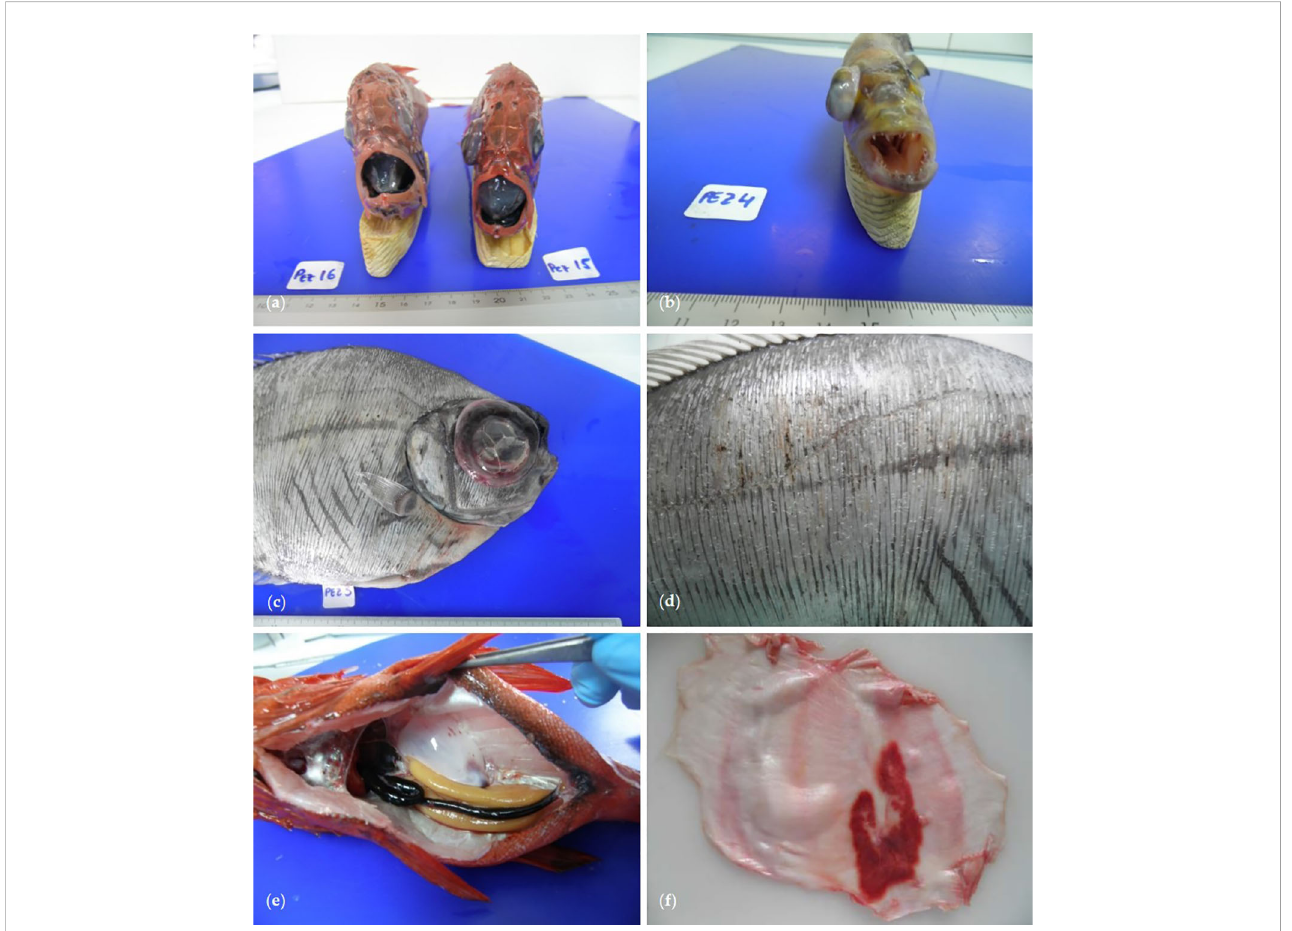
FIGURE 3 Macroscopy fi ndings in fi shes from El Hierro volcano. (A) Gastric eversion in two specimens of Hoplostethus mediterraneus . (B) Exophthalmia unilateral in a specimen Serranus atricauda . (C) Gas bubbles in cornea in a specimen of Grammicolepis brachiusculus . (D) . Gas bubbles in skin in a specimen of Grammicolepis brachiusculus . (E) Over-in fl ation of the swim bladder and hemorrhages in a specimen of Hoplostethus mediterraneus . (F) Severe congestion of the rete mirabile in a specimen of Balistes carolinensis